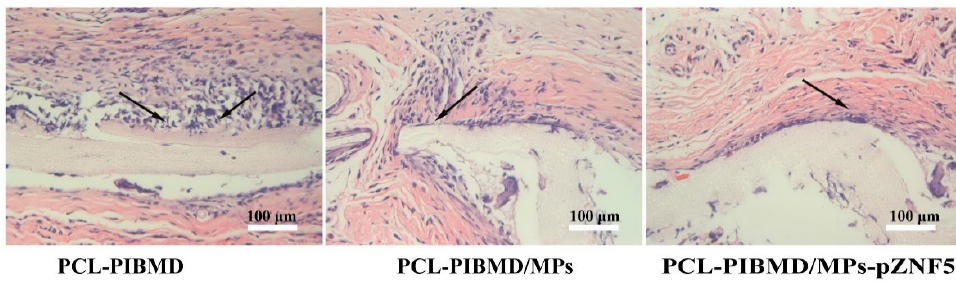
Figure 7. H&E micrographs of subcutaneous implanted PCL-PIBMD, PCL-PIBMD/MPs and PCL-PIBMD/MPs-pZNF580 specimens for 7 days. The inflammatory cells were marked by black arrow.